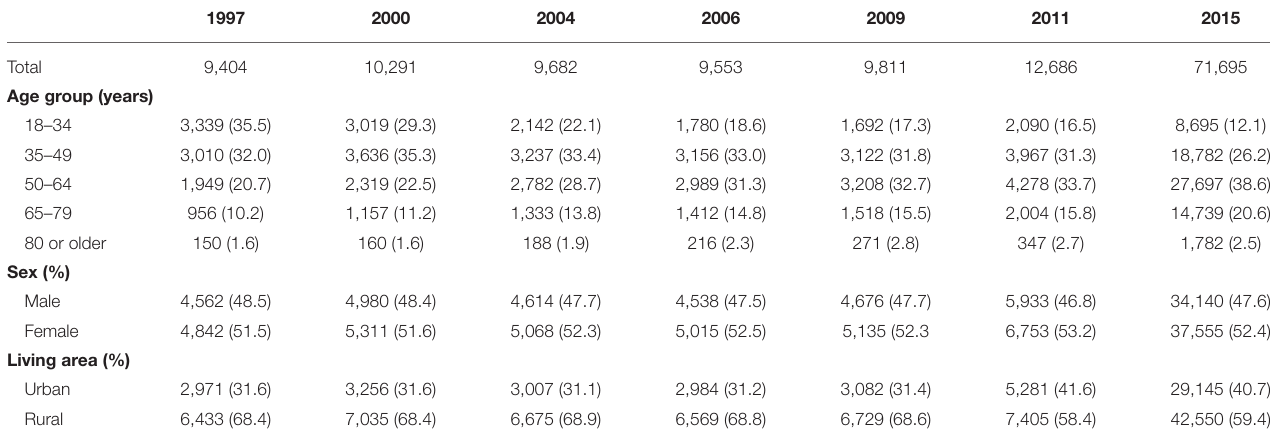
TABLE 1 | Sociodemographic distribution of participants in the